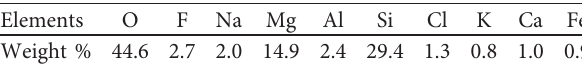
Figure 4: SEM-EDX micrograph of the Rh-CTAB. Table 3: Chemical elements of the Rh-P in %.